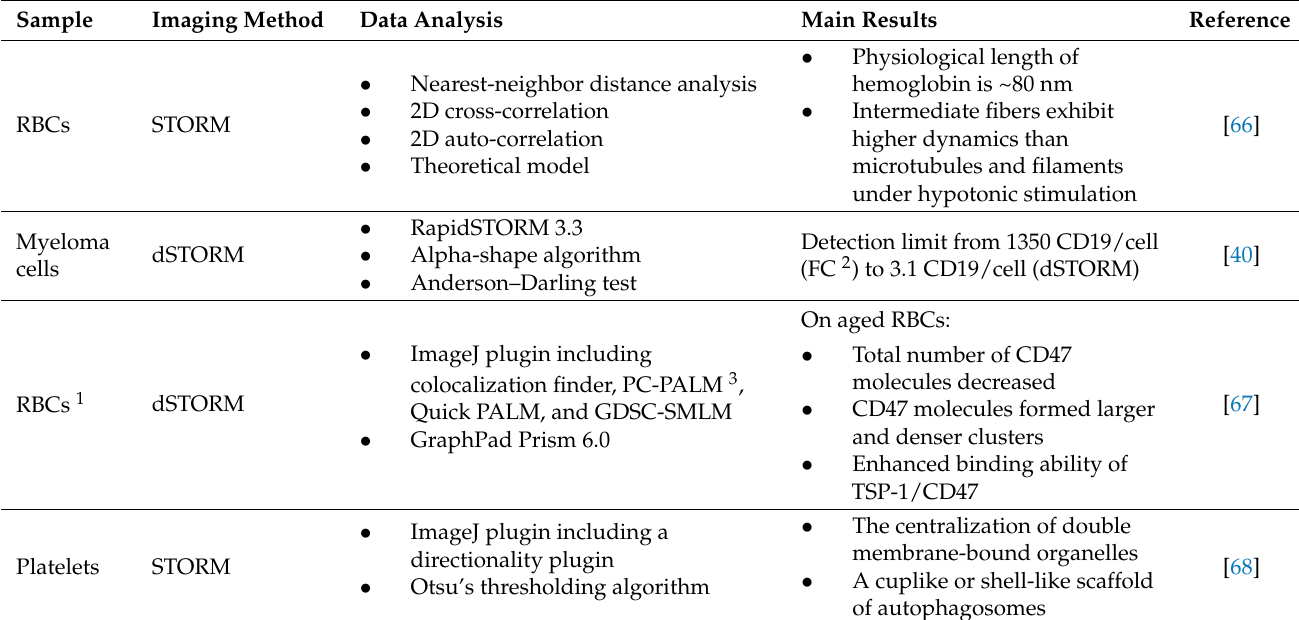
Table 3. Some applications of SMLM in blood cell